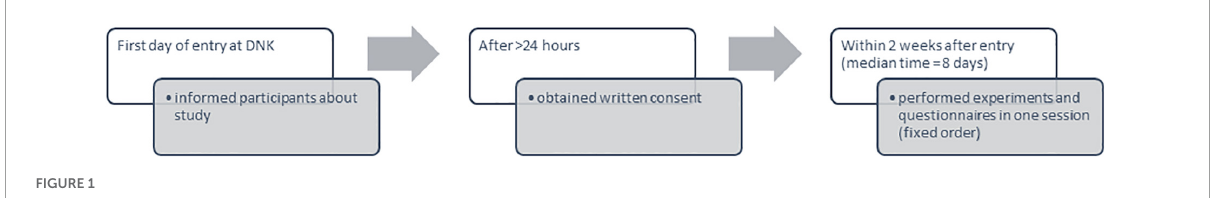
FIGURE1 Timeline of recruitment and